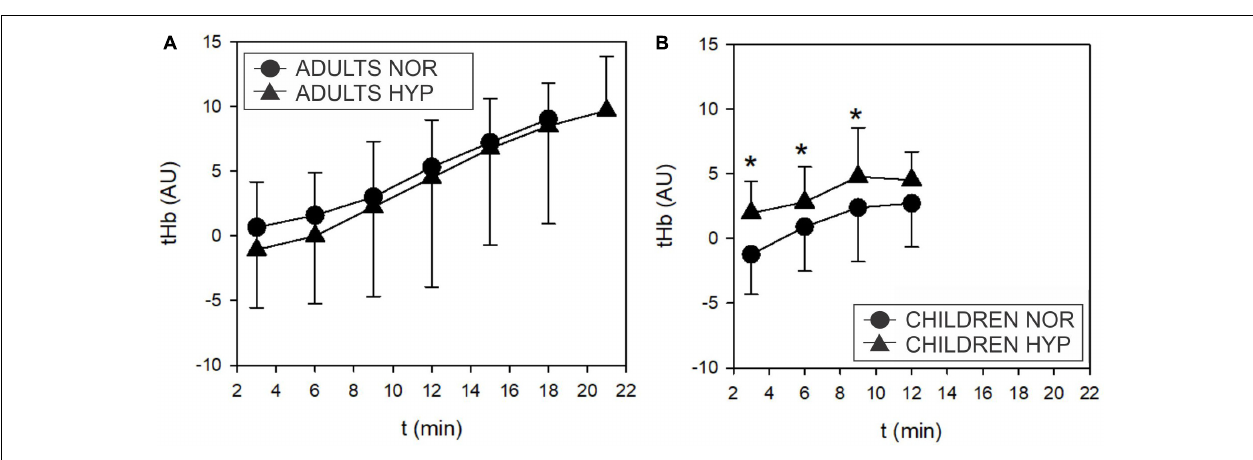
FIGURE 6 | Time course of the changes in total muscle hemoglobin (tHb) concentrations during the incremental test in adults (A) and children (B) . Adults didn’t show any influence of hypoxia on tHb. However, children displayed higher tHb values in hypoxia compared to normoxia ( (cid:49) ; F = 7.618, p =